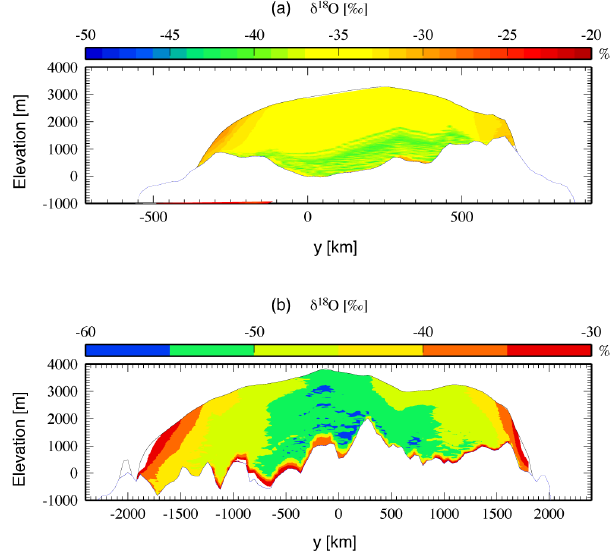
Figure 16. Two cross sections of the (a) Greenland and (b) Antarc- tic ice sheets showing the δ 18 O distribution close to the GRIP and Vostok ice